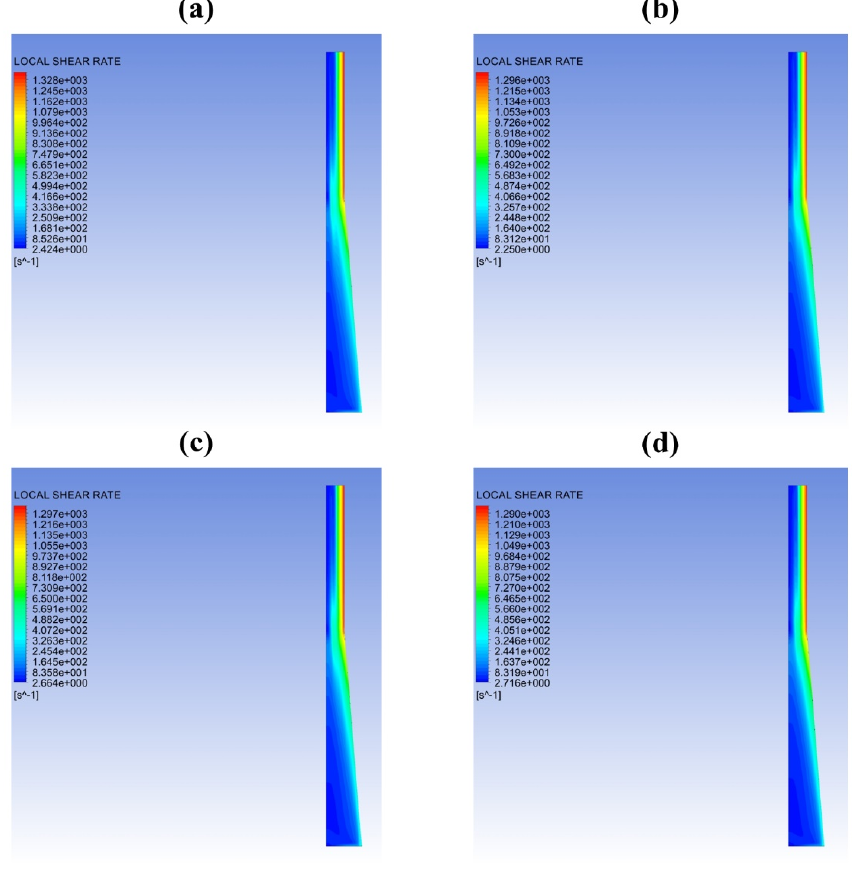
Figure 5. Shear rate contours along the die channel for PET melts at different temperatures with 900 mm 3 /s: ( a ) 271 °C; ( b ) 274 °C; ( c ) 277 °C; ( d ) 280 °C.